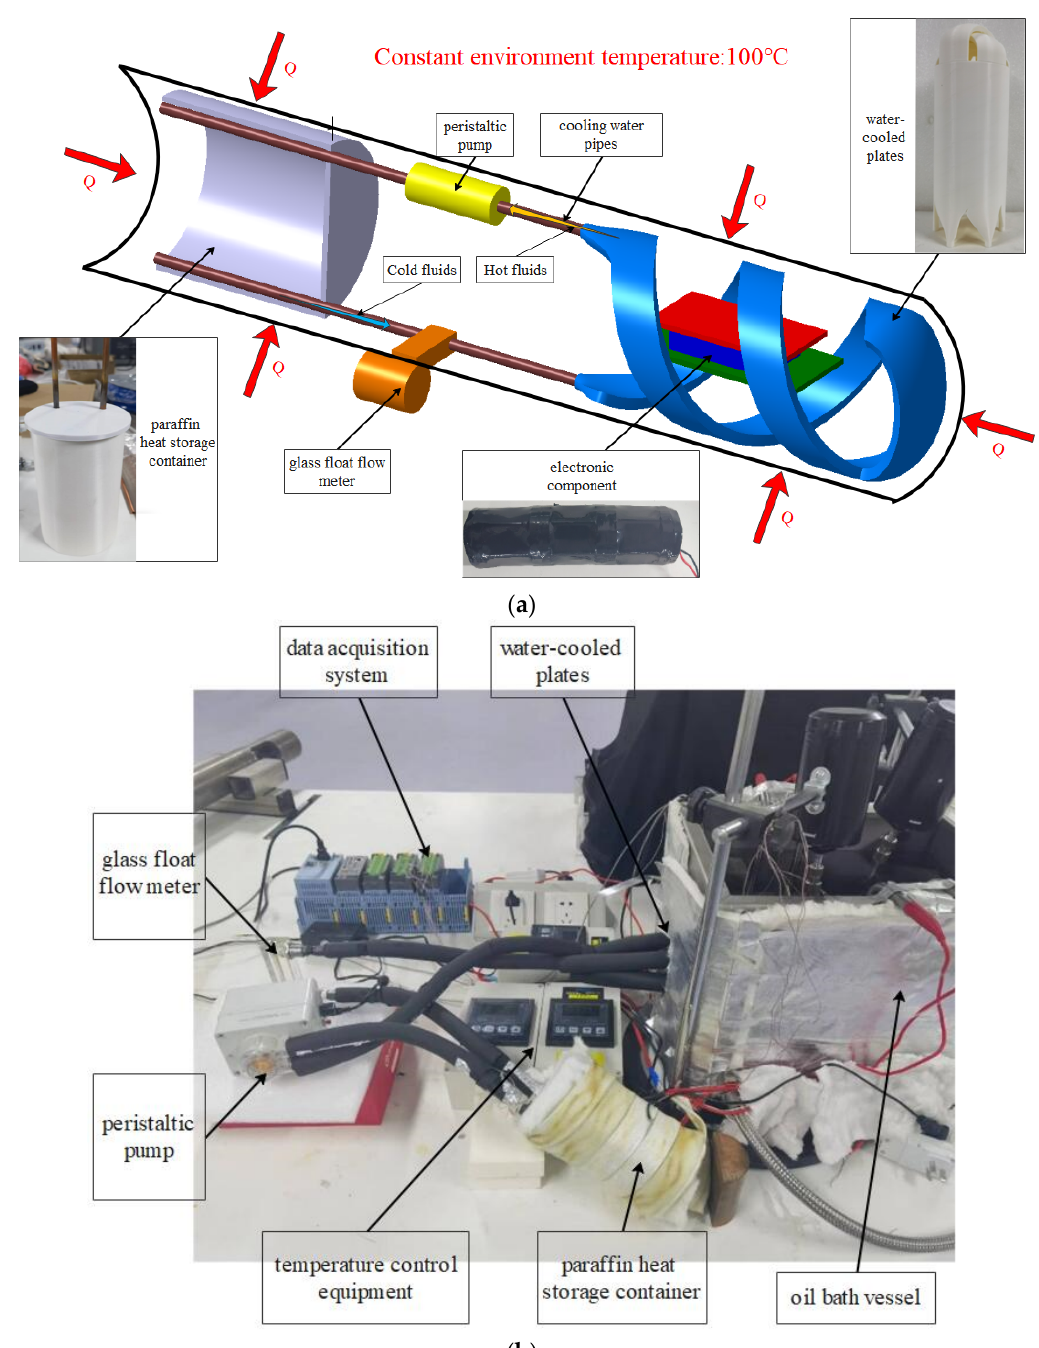
Figure 2. Illustration of experimental system. ( a ) Schematic diagram. ( b ) Actual setup. Liquid water at a constant pressure liquid was applied as working medium in pre- sent study, and a variable − frequency peristaltic water pump was used, with a flowrate ranging from 50 to 470 mL/min. The pump might drive the working medium into the annular cooling plate. Next, after it was heated by the wall of simulated well, the working fluid was pumped into the PCM thermal storage container, where the heat was released. A glass − float flow meter was arranged for real − time monitoring of the flowrate; therefore, the system constituted a water − cooling cycle from the loop of pump, passing through the